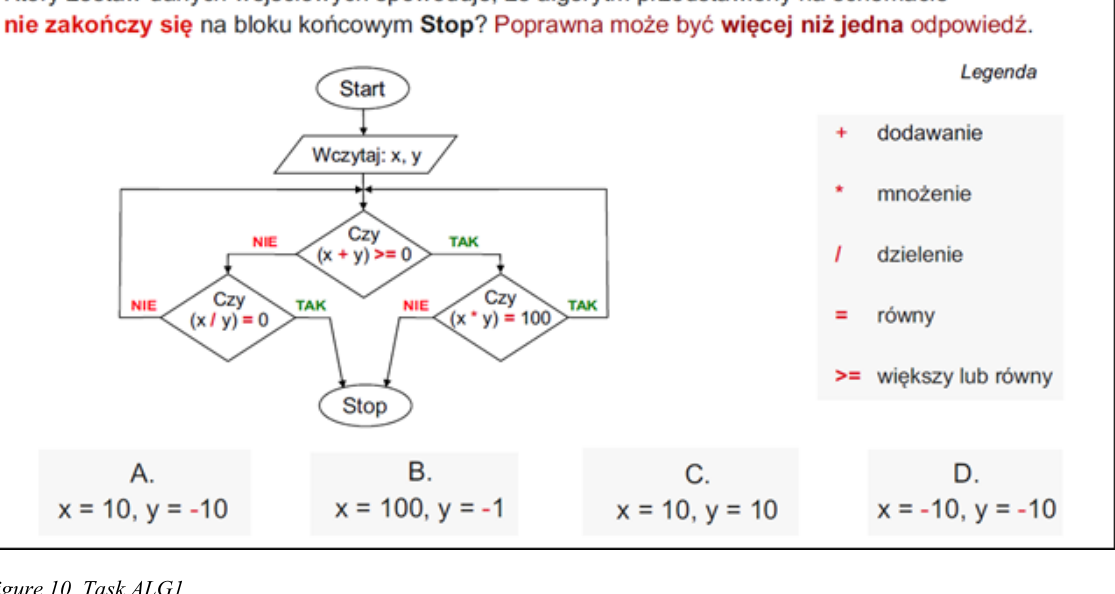
Figure 10. Task ALG1.